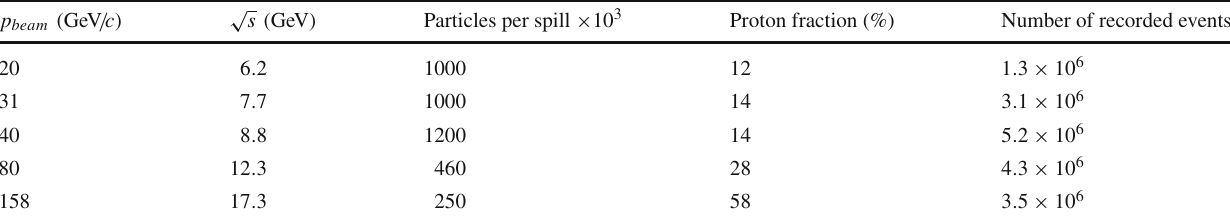
Table 1 Basic beam properties and number of events recorded for p + p interactions at incident proton momentum of 20, 31, 40, 80 and 158 GeV / c √ p beam ( GeV / c ) s ( GeV ) Particles per spill × 10 3 Proton fraction (%) Number of recorded